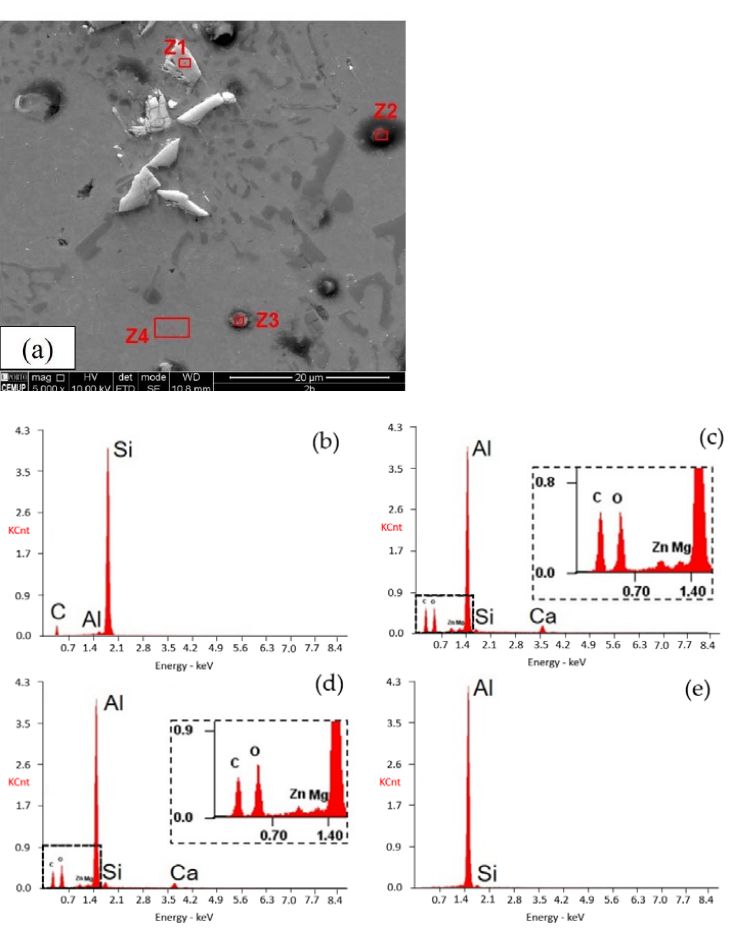
Figure 8. SEM characterization of the sample of Condition 1-Position (1b). ( a ) SEM micrograph; EDS in areas ( b ) Z1; ( c ) Z2; ( d ) Z3; and ( e ) Z4.